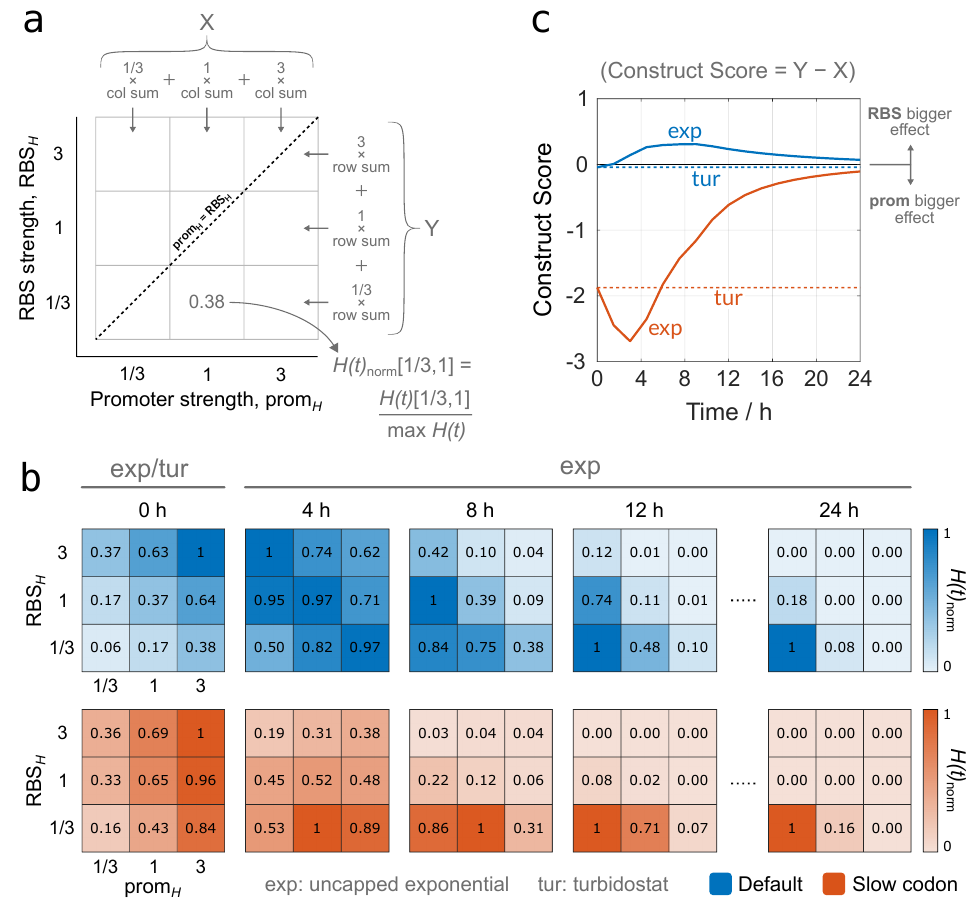
Figure 6. Evaluating the performance of gene construct design in terms of heterologous protein yield by calculating H ( t ) norm in different growth scenarios. ( a ) An illustration of the grid space used to form heat maps of H ( t ) norm (subfigure b) and the Construct Score (Subfigure c). The line = RBS ( t ) norm prom H is used to compare the effects of prom H and RBS H . ( b ) Heat maps of H H at successive time points for cases without (blue) and with (orange) a slow codon. For the label “ t = 0h”, calculations are made over a small non-zero time interval (10 − 12 h). Beyond t = 0h, we provide heat maps only for H ( t ) exp because the dynamics for H ( t ) tur remain unchanged. ( c ) Comparing the effect of promoter and RBS strengths on H ( t ) exp and H ( t ) tur via the “Construct Score”. A value of zero indicates that increasing prom and RBS H by the same amount would have H an equivalent effect on protein yield, while positive and negative values indicate that a greater effect on yield would be obtained by increasing prom or RBS H , respectively. Dashed lines indicate the H Construct Score when using a